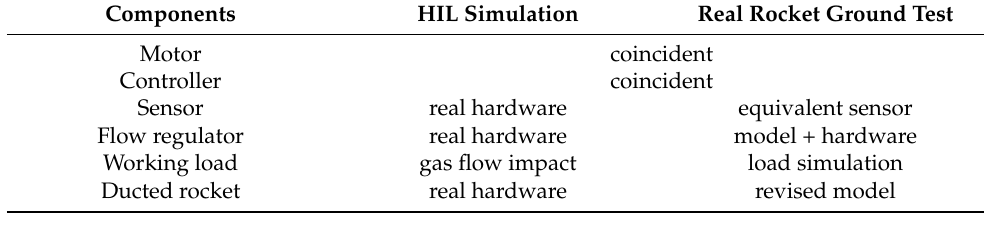
Table 1. Comparison between the HIL simulation and direct-connected ground test.